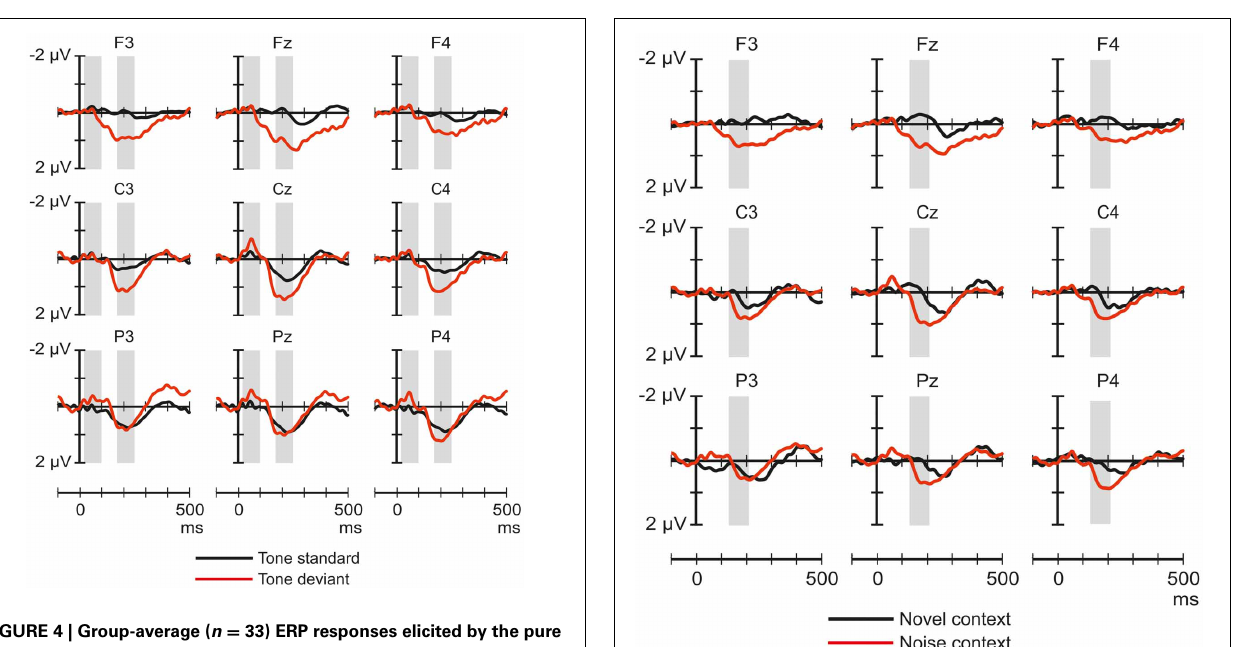
FIGURE 4 | Group-average ( n = 33) ERP responses elicited by the pure tones in the noise-deviant (tone standard; black line) and noise-standard (tone deviant; red) conditions at frontal, central and parietal scalp locations. Amplitude measurement windows are indicated by gray bars.